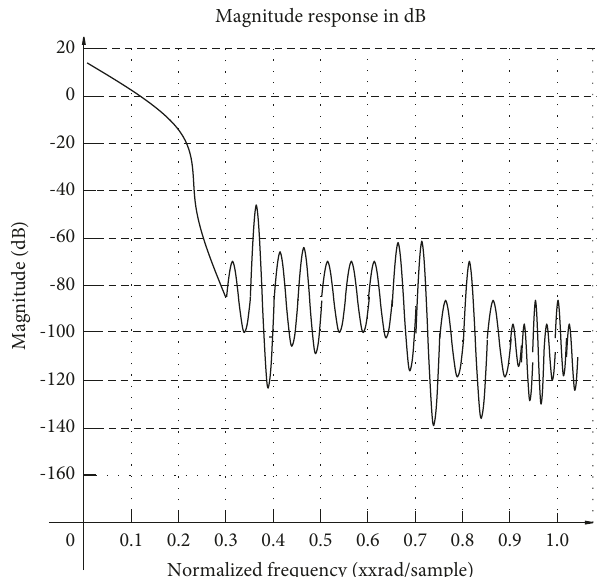
Figure 8: FIR low-pass filter tonnage response with a normalized cutoff frequency of $0.2.